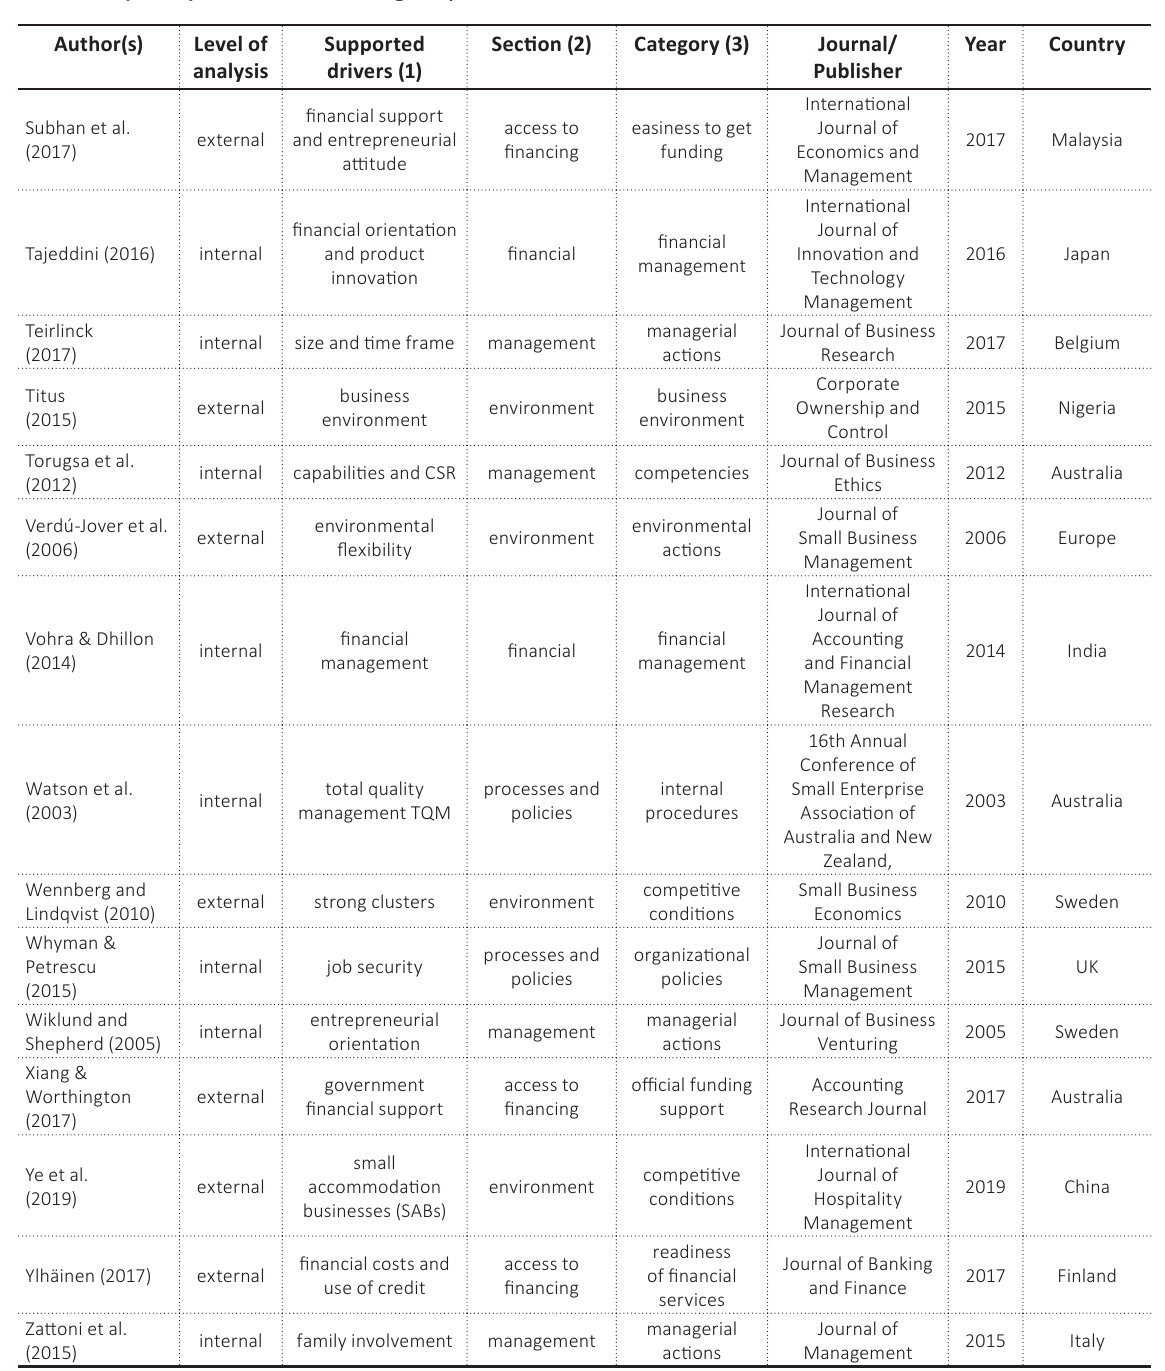
Table A1 (cont.). Full list of contingency